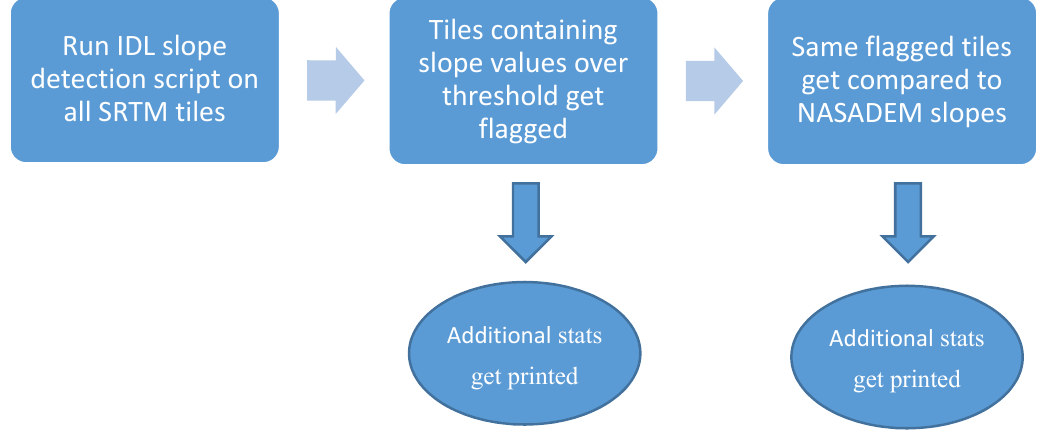
Figure 8. Schematic flow of the slope detection algorithm.